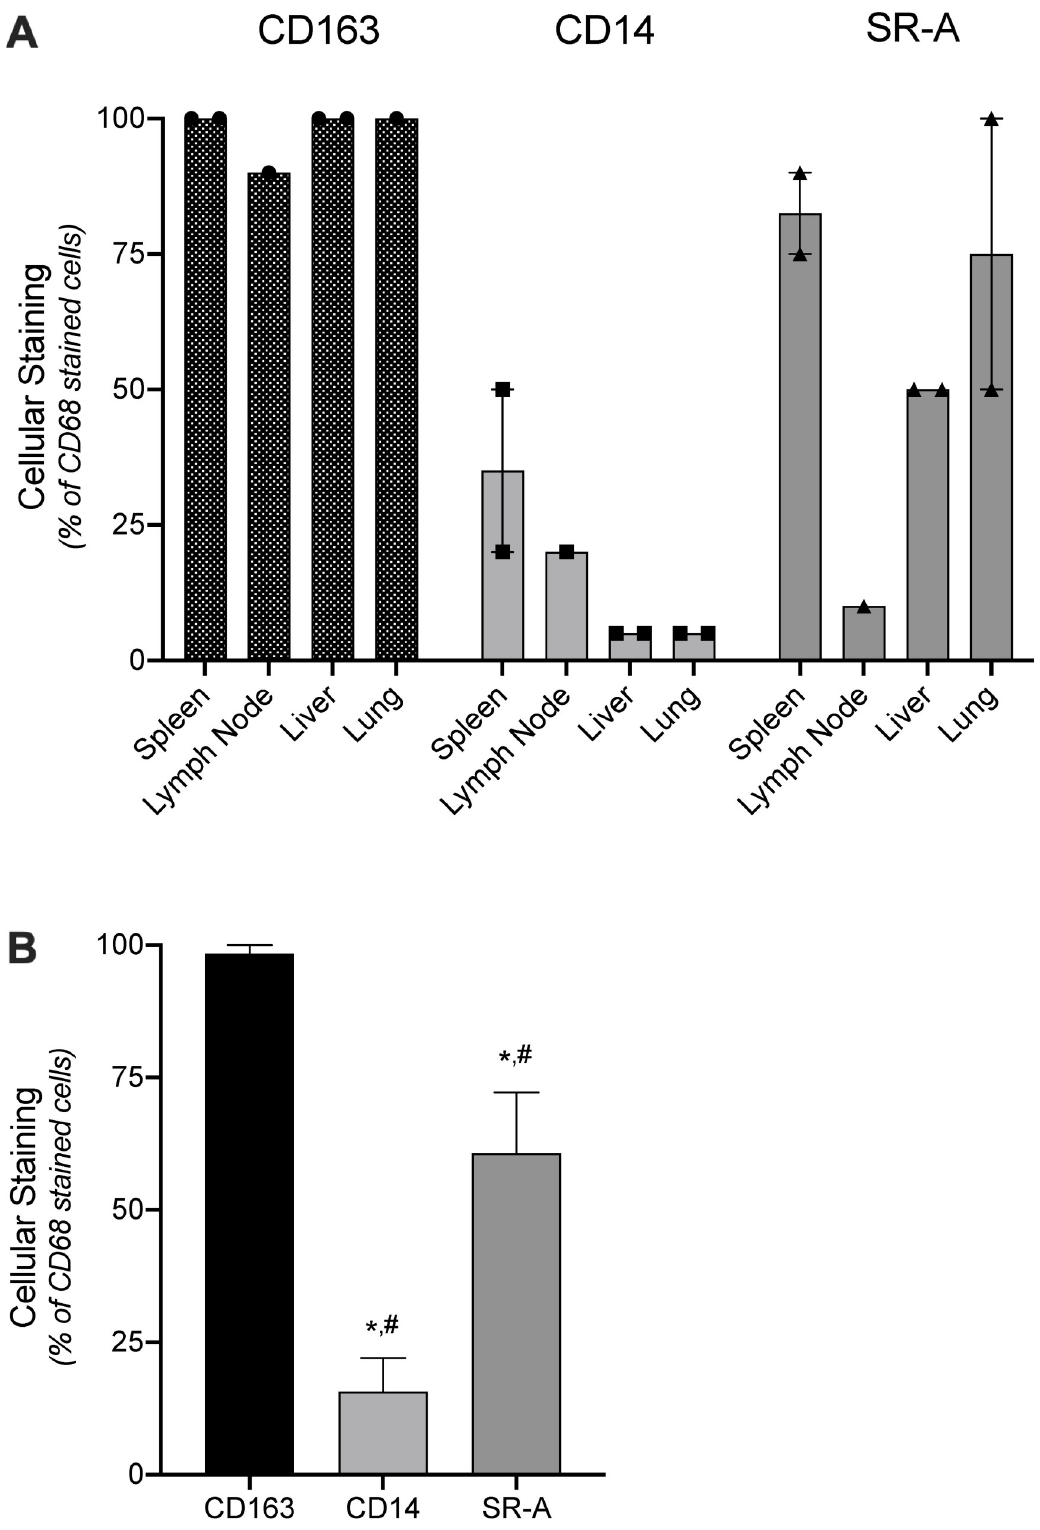
Fig 4. Analysis of CD163, CD14 and SR-A expression compared to CD68 in resident tissue monocyte/macrophages. A) Tissue-resident monocyte/macrophages in FFPE sections of spleen, lymph node, liver, and lung were immunostained and scored